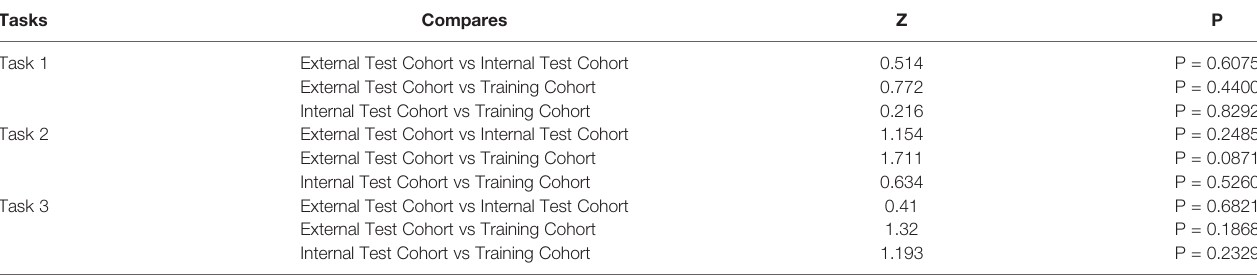
TABLE 5 | DeLong Test between Training Cohort, Internal Test Cohort, and External Test Cohort in tasks 1 – 3. Tasks